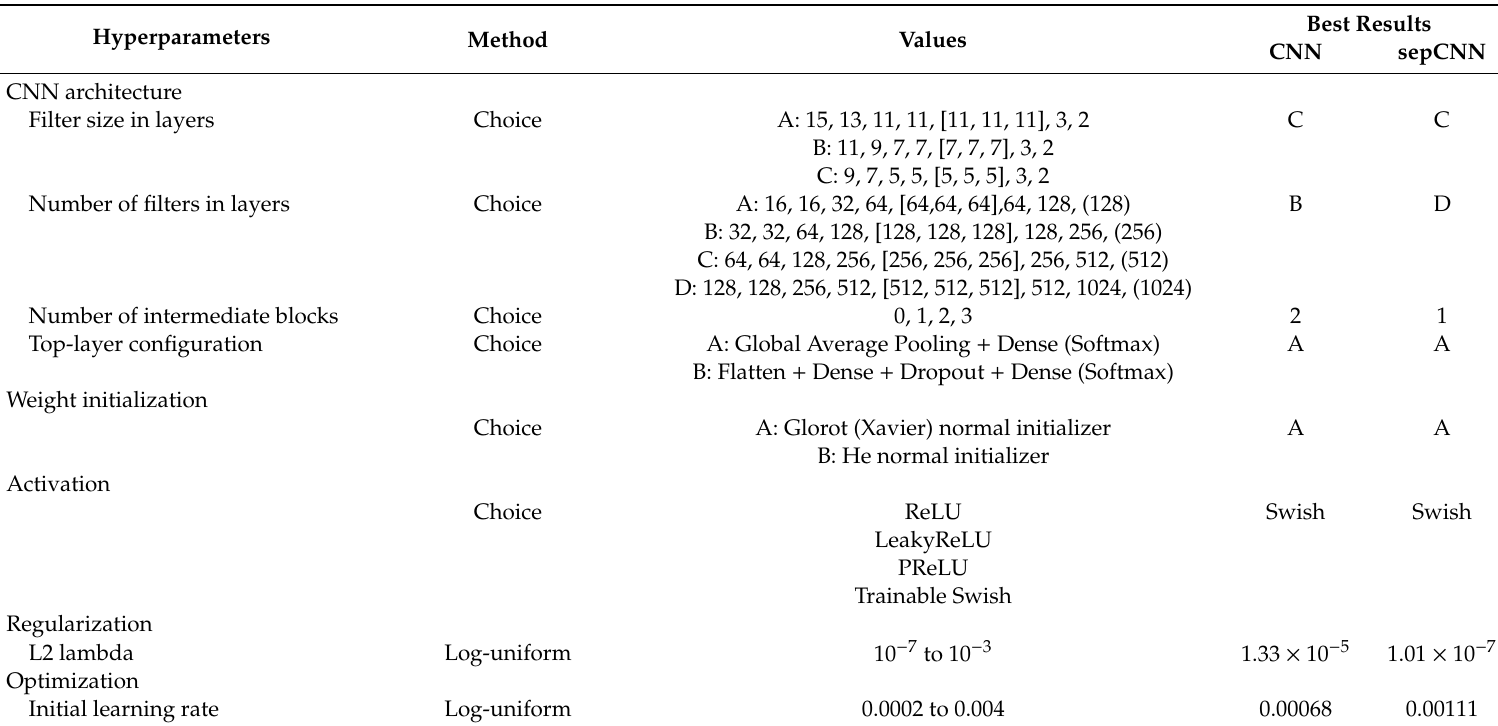
Table 1. Hyperparameter tuning. Bayesian optimization was used to explore the hyperparameter space in 300 trials. The optimal choices are shown in the last two